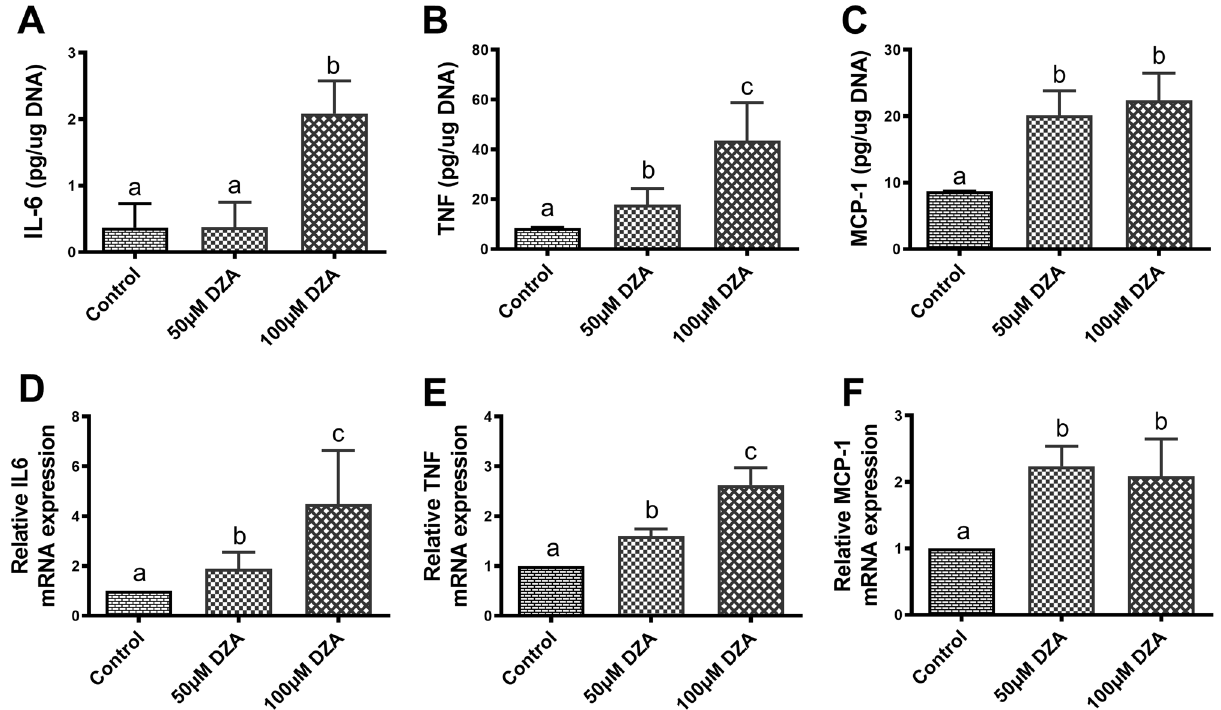
Figure 7. DZA promotes the release of inflammatory cytokines from 3T3-L1 adipocytes. Quantification of proinflammatory cytokines ( A ) IL-6, ( B ) TNF and ( C ) MCP-1 in the spent medium of control and DZA-treated 3T3-L1 adipocytes normalized to cellular DNA and expressed as µg/µg DNA (n = 5). Relative mRNA expression levels of ( D ) IL-6, ( E ) TNF and ( F ) MCP-1 in control and DZA-treated 3T3-L1 adipocytes (n = 5). Data are presented as the mean ± SEM; values not sharing a common letter significantly differ from each other at p ≤